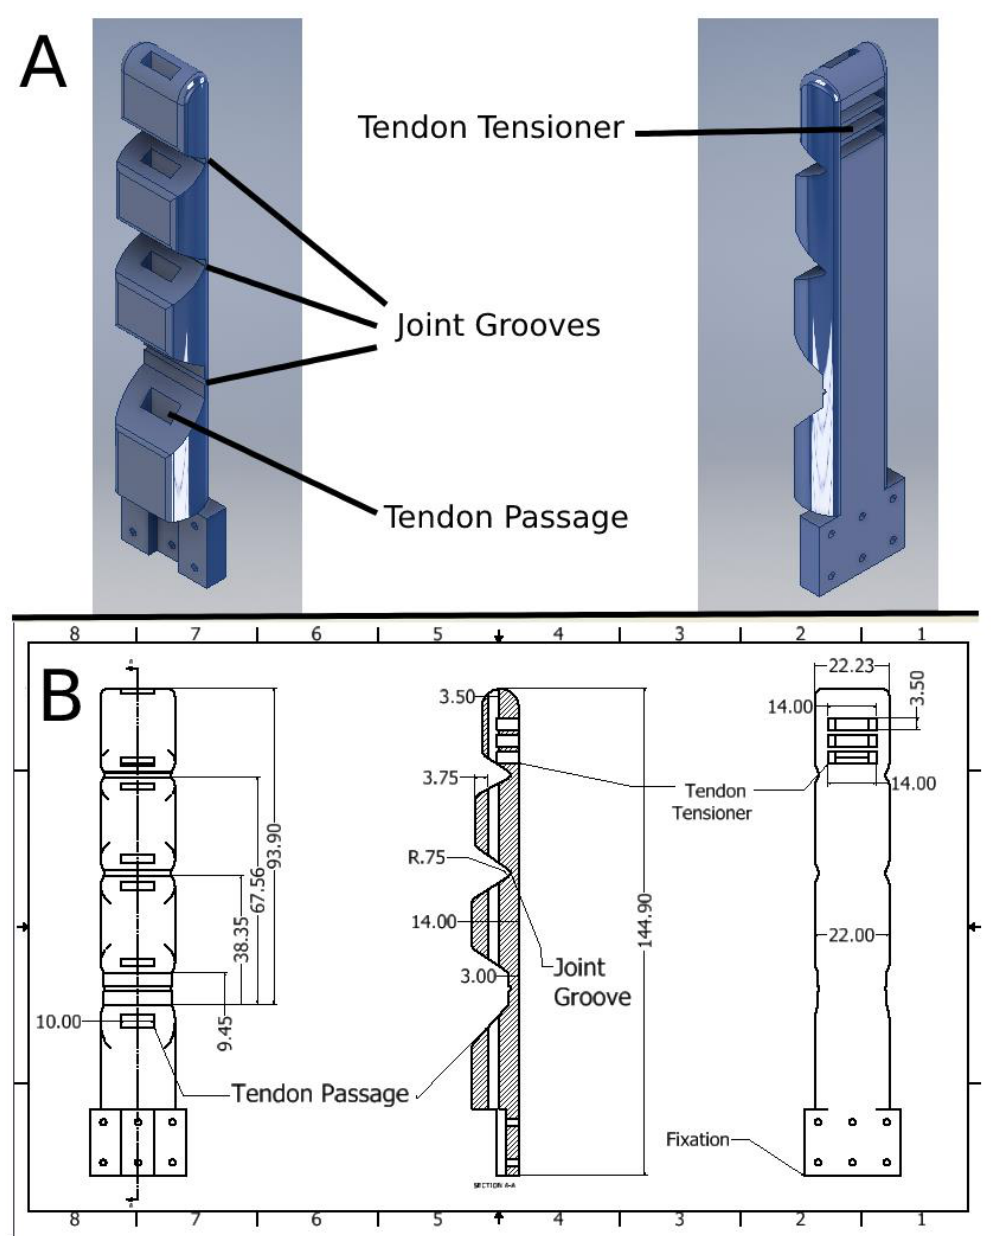
Figure 1. ( A ) The CAD model of the monolithic structure finger design. ( B ) An engineering drawing detailing the dimensions of the finger.